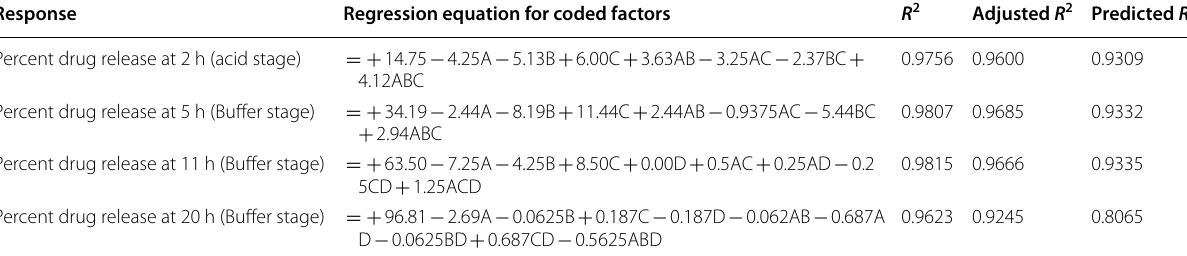
Table 11 The regression equation obtained for percent drug release